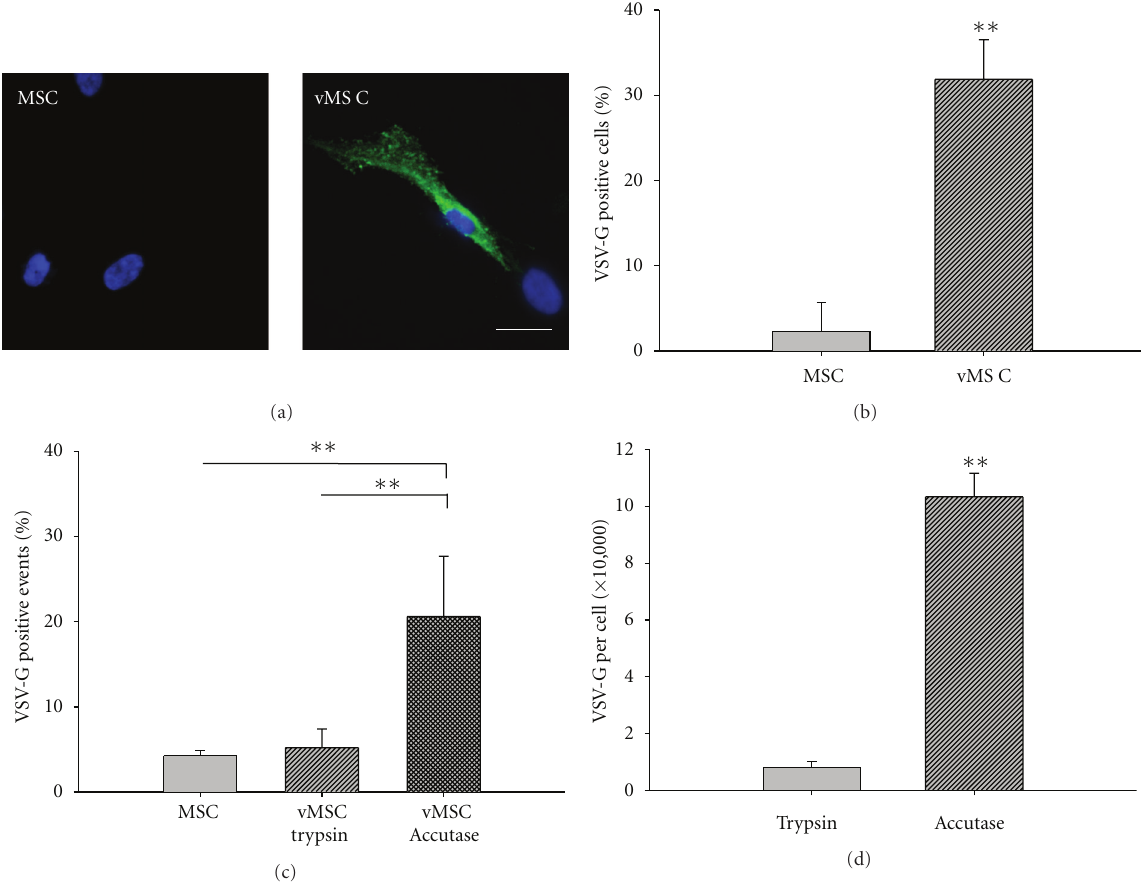
Figure 1: Expression of VSV-G in MSCs. VSV-G expression was analyzed via immunofluorescence using an anti-VSV-G-FITC antibody. (a) Representative image analysis of untransfected MSCs and vMSCs; VSV-G (green); DAPI (blue). Scale bar = 25 μ m. (b) Transfection e ffi ciency was defined as the number of VSV-G-positive cells divided by the total number of nuclei and is reported as the mean ± standard deviation. A low level of nonspecific binding was associated with the anti-VSV-G antibody and is reflected in the percentage of positive cells reported in the untransfected population of MSCs (2 . 3% ± 3 . 4%). (c) Dissociation reagent impacts VSV-G expression. Trypsin treatment reduces detection of VSV-G expressing cells to that of untransfected MSCs. Accutase treatment retains a significantly greater number of cells expressing VSV-G than treatment with trypsin; ∗∗ P < 0 . 005. (d) Dissociation reagent impacts the number of VSV-G proteins per cell. The number of VSV-G proteins expressed per cell is significantly reduced with trypsin treatment as compared with Accutase treatment, which was quantified utilizing Quantum Simply Cellular standards; ∗∗ P < 0 .